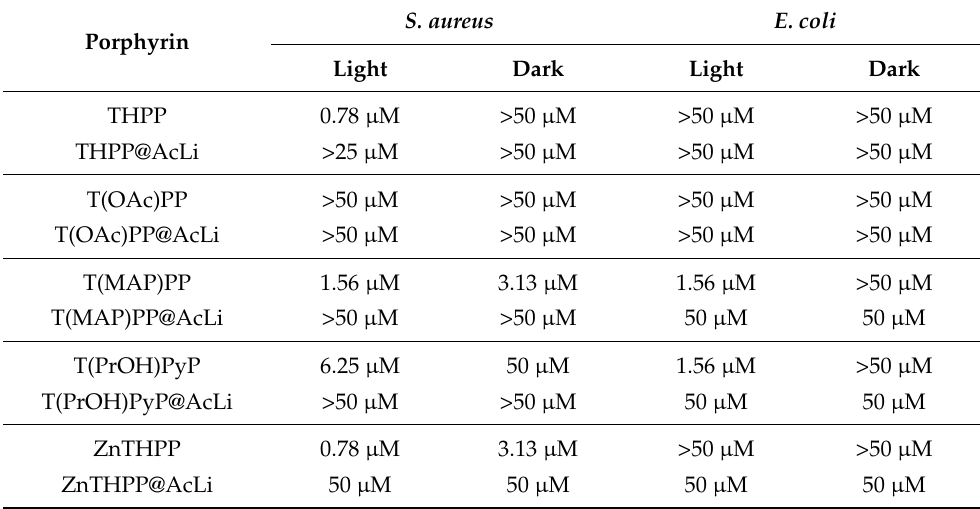
Table 5. Minimal inhibitory concentrations found for S. aureus and E. coli , when treated with the free or encapsulated porphyrins. Irradiated bacteria were incubated with the treatment for 30 min, before irradiation under blue-LED light (15 J/cm 2 ). S. Porphyrin